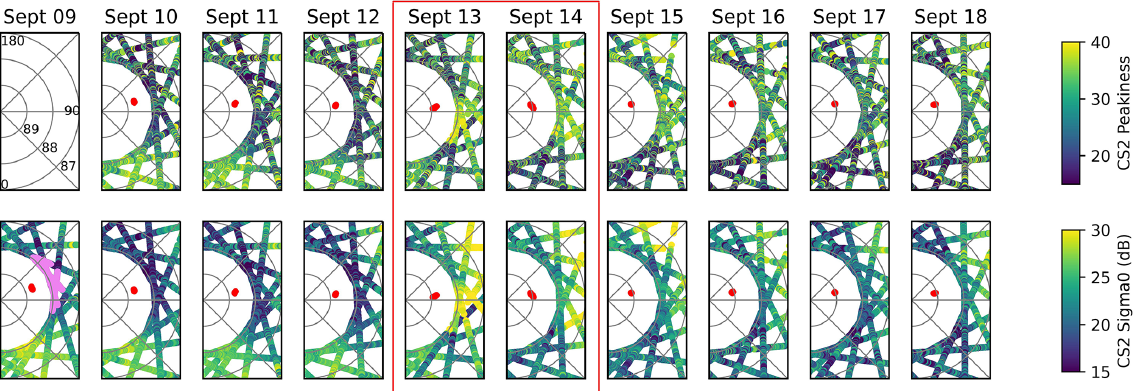
Figure 7. CryoSat-2 peakiness (top) and sigma0 (bottom) before, during, and after the ROS events on 13 to 14 September (red box). Only waveforms with peakiness less than 40 are shown, as this is the cutoff for classification as a sea ice floe within the ice pack (waveforms with peakiness greater than 40 are classified as originating from leads.) Red circles indicate the locations at which KuKa collected data on that date. Lines of latitude and longitude are indicated in the top right panel, and the lilac points in the bottom left panel show CryoSat-2 data points within 130km of KuKa, from which the averaged quantities shown in Fig. 8 are determined.